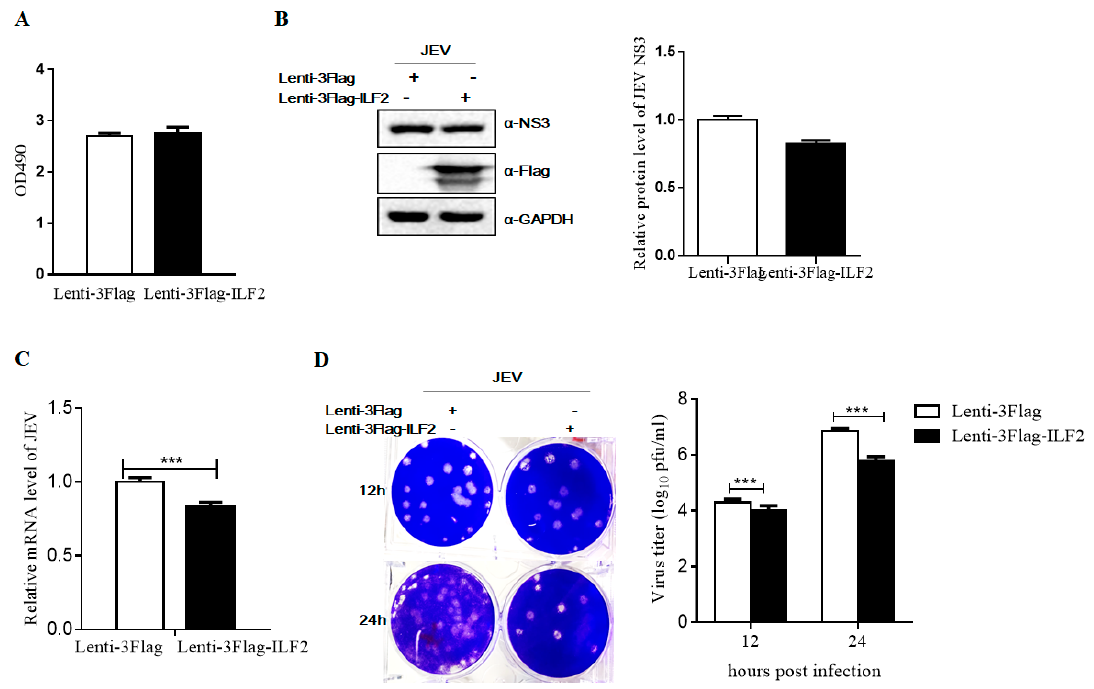
Figure 6. Overexpression of ILF2 inhibits JEV replication in 293T cells. 293T cells were transduced with lentiviruses expressing ILF2 (Lenti-3Flag-ILF2) or a control lentivirus (Lenti-3Flag) for 48 h and the proliferation of overexpressing ILF2 293T cells was analyzed by MTS assay. ( A ) Cells were infected with JEV at an MOI of 1.0 for 12 h or 24 h. Cells supernatants and total RNA were harvested for the indicated experiments. The antiviral activity of ILF2 against JEV infection was evaluated with different experiments. ( B ) Western blot analysis of the protein level of JEV NS3 was performed using the indicated antibodies. GAPDH served as the loading control at an equal sample loading. ( C ) The relative quantification of intracellular JEV C gene copies by real-time PCR analysis. ( D ) The production of progeny virus in culture supernatants was measured by plaque assay. The plaque formation ability was observed in BHK-21cells (left) and virus titer was calculated (right). Three asterisks indicate that a statistical difference exists between overexpressing ILF2 293T cells and control cells at p < 0.001.